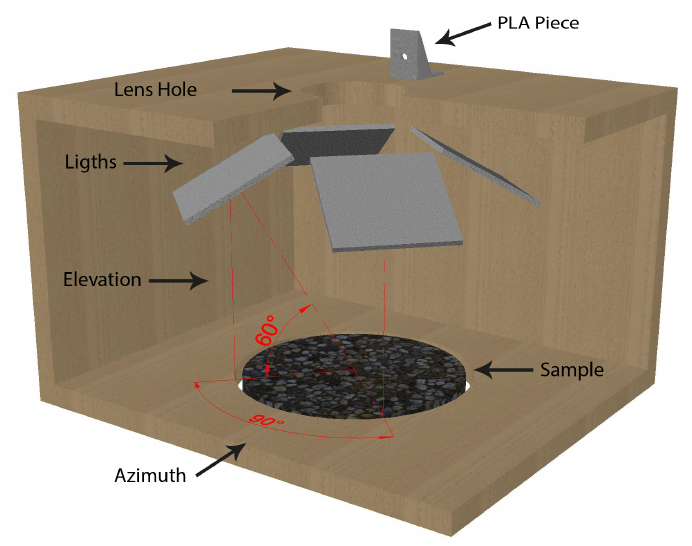
Figure 11. Interior box